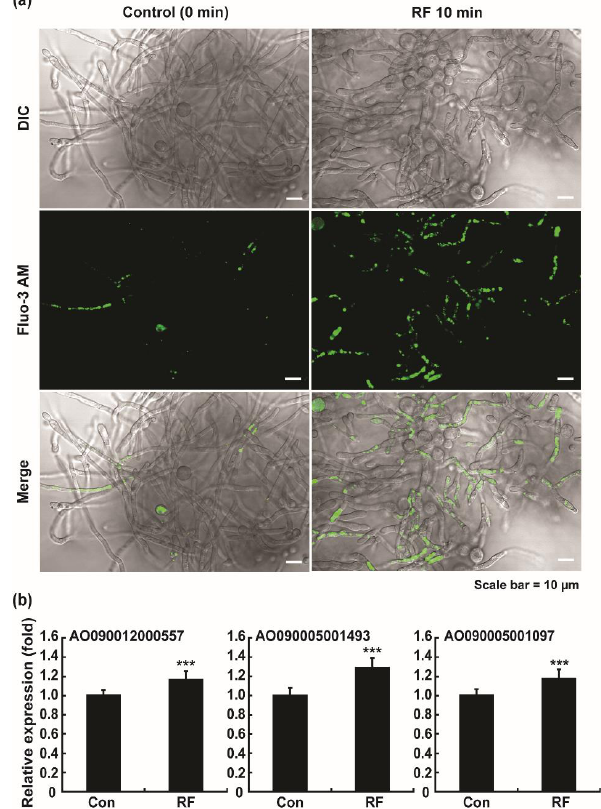
Figure 7. Assay for intracellular Ca 2+ using Fluo-3 AM ( a ) and level of transcription of three phospholipase C (PLC) genes ( b ) in fungal hyphae at 16 h after no exposure (control) or RF-EMF exposure (2 GHz, 0.01 W) for 10 min. In ( b ), each value represents the mean of nine replicate measurements. The experiment was repeated three times, each with three replicate measurements: *** p < 0.001.